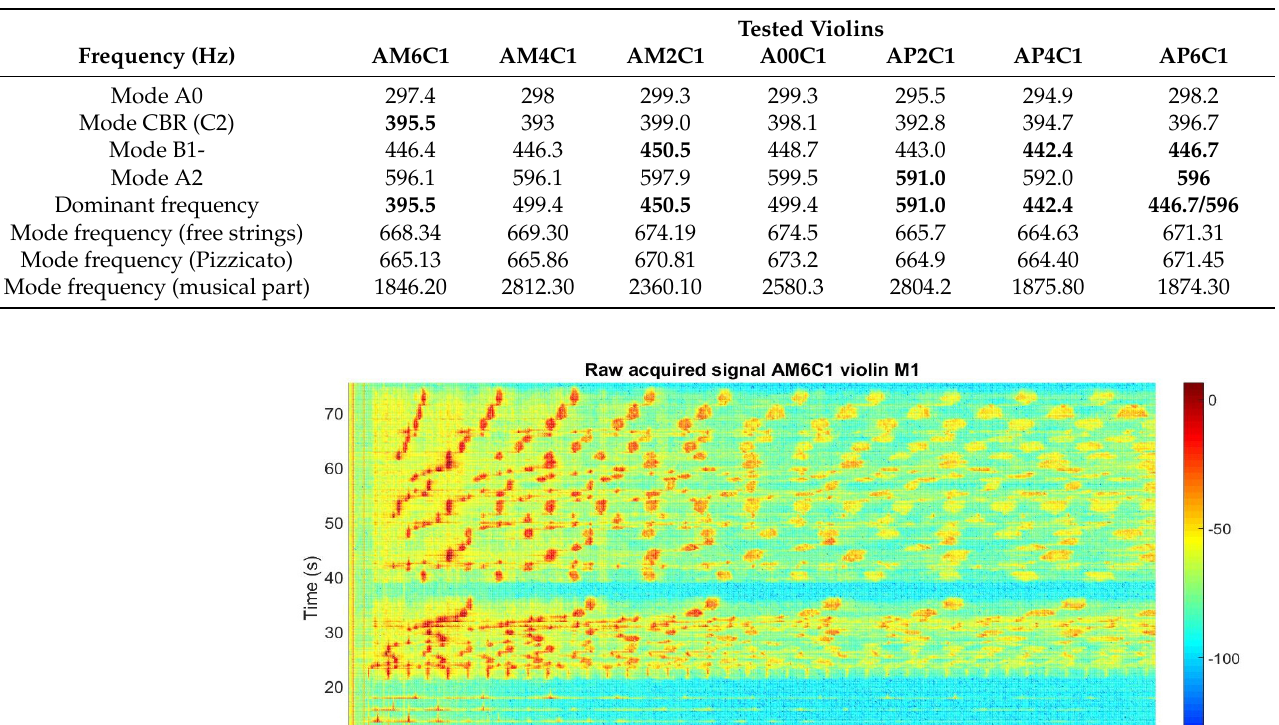
Table 1. The main frequencies extracted from frequency domain analysis. The bold values correspond to higher amplitudes from all frequency spectrums.